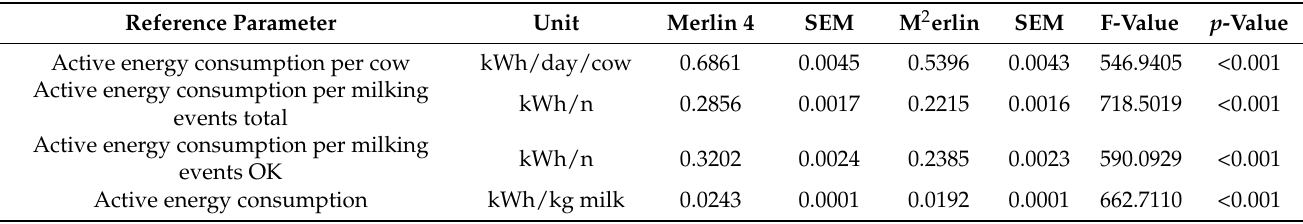
Table 4. A comparison of the active energy consumption of the Merlin 4 and M 2 erlin AMS configuration related to selected production parameters.